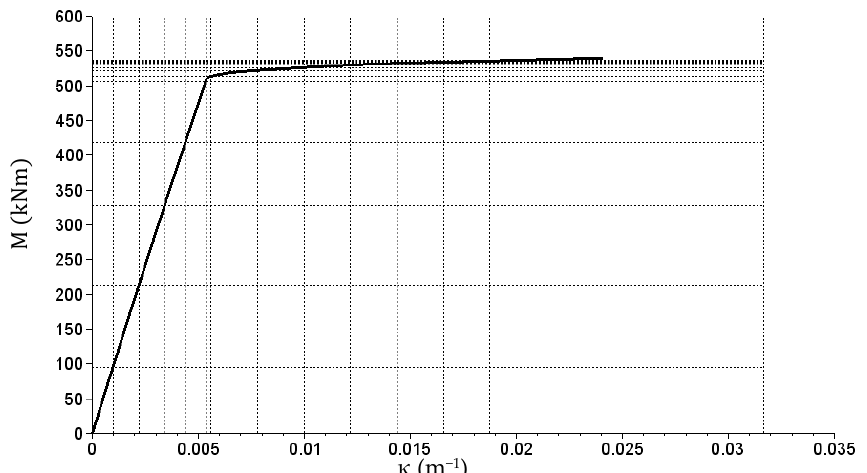
Figure 19. The M ( κ ) relation graph corresponding to the E p matrix (reinforcement of 8 Ø20). The problem was solved with the finite difference method and the incremental algo- rithm incorporating stiffness matrices that was discussed earlier and used in previous problems. The beam undergone discretization assuming a digitizing range of 0.1 m. One load cycle for the beam and the subsequent relief was assumed. Maximum load value of q = 160 kN/m was chosen so that the plasticization effect of beam sections could be clearly seen during the simulation. Building the load increment vector, the load phase was divided into two ranges. The first range, covering the force range from 0 to 0.95 q (i.e., up to the value of 144 kN/m), was divided into 15 subranges with an increment of 9.60 kN/m. The second range, covering the force range from 0.95 q to q (i.e., from 144 to 160 kN/m), was divided into 15 subranges with an increment of 1.067 kN/m. The load phase (from the value q = 160 kN/m to 0) was divided into 15 subranges with an increment of 10.67 kN/m. The displacement (deflection) graph obtained during specific steps (for successive load values in the load and relief phases) is shown in Figure 20. The x axis describes the coordinates of the beam sections starting from the leftmost support.